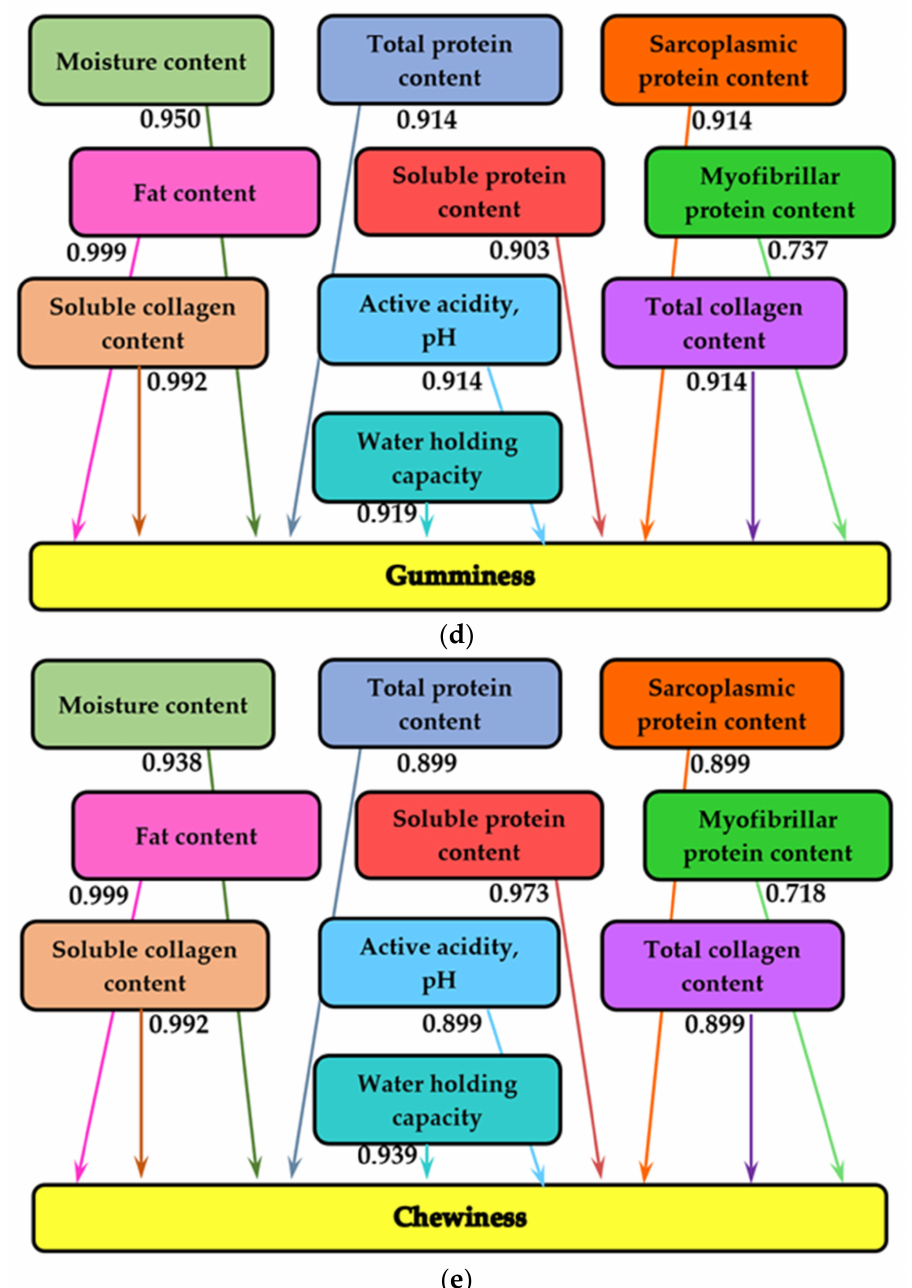
Figure 2. Analysis of mutual information on the influence of physicochemical indicators on texture profile parameters: ( a ) hardness; ( b ) cohesiveness; ( c ) springiness; ( d ) gumminess; ( e )